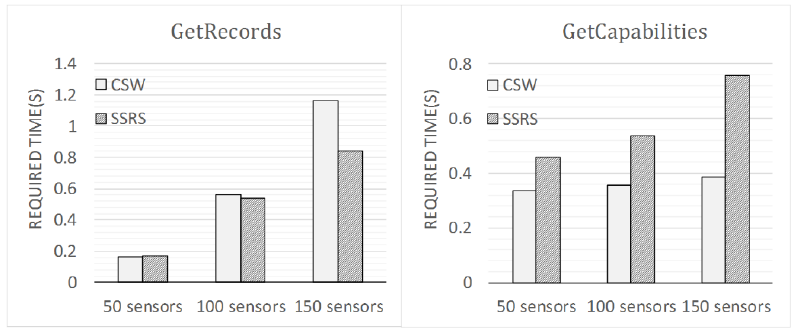
Figure 8. The mean time required for two operations in CSW and SSRS.